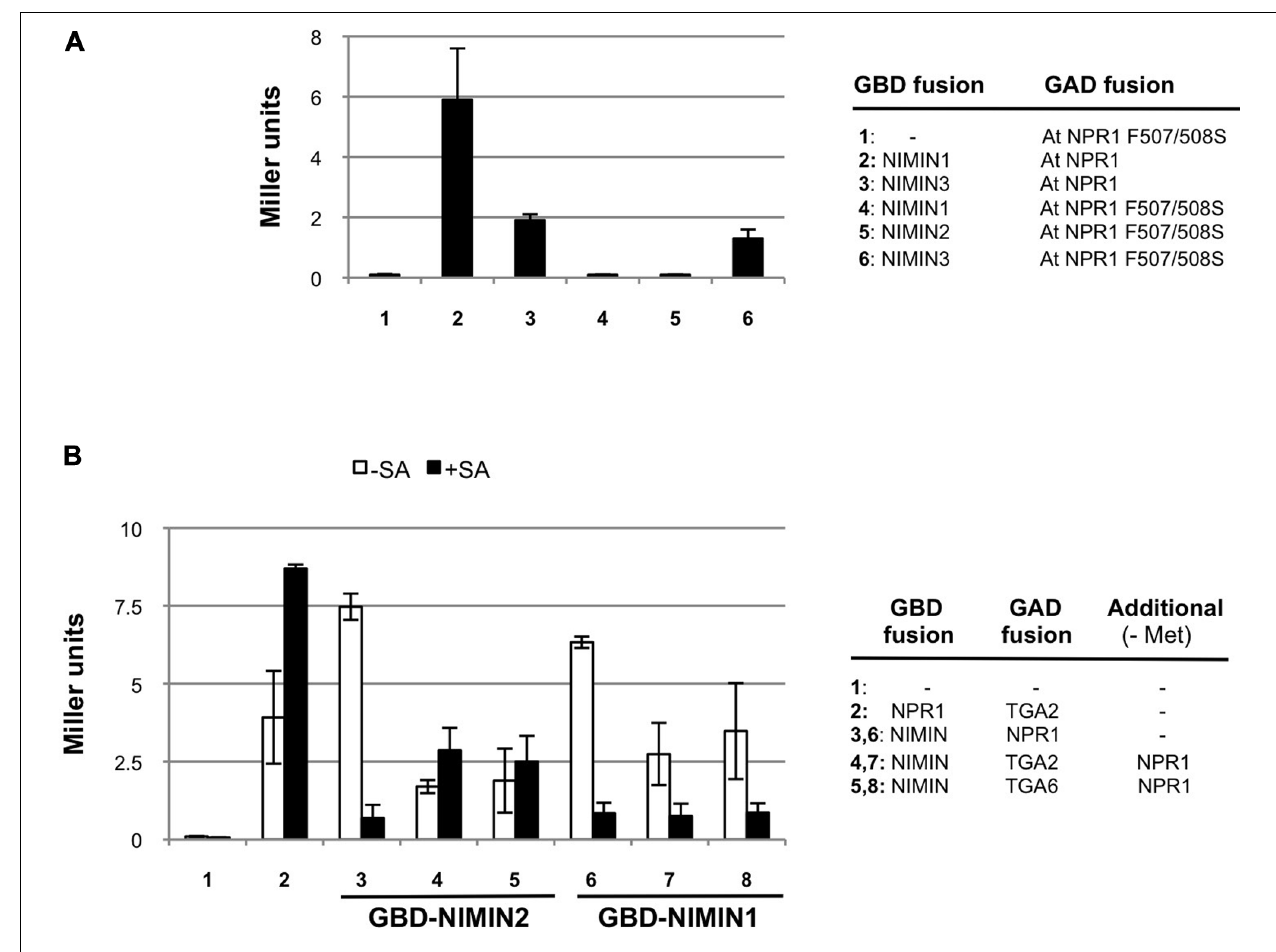
FIGURE 6 | Arabidopsis NIMIN1 and NIMIN2 interact differentially with At NPR1 in yeast. (A) Yeast two-hybrid interaction of NIMIN1, NIMIN2 or NIMIN3 expressed as GBD fusions with the mutant protein At NPR1 F507/508S expressed as GAD fusion. Interactions of GAD-At NPR1 with GBD-NIMIN1 and GBD-NIMIN3 serve as positive controls. (B) Effect of SA on